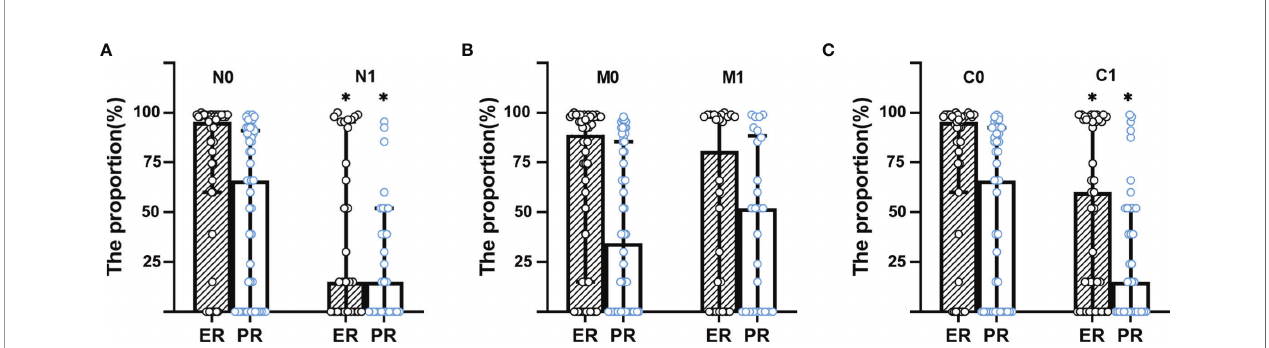
FIGURE 2 | Box plot for the proportion of ER and PR distribution between groups. (A) Box plot for the proportion of ER and PR distribution between N group. (B) Box plot for the proportion of ER and PR distribution between M group. (C) Box plot for the proportion of ER and PR distribution between C group. N0, no